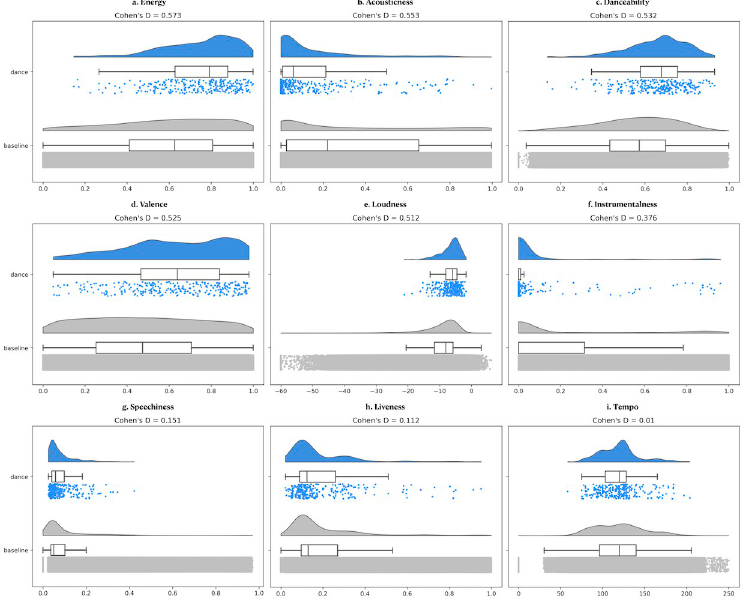
Fig 1. Spotify audio features comparing baseline (grey) and dance (blue) music datasets. Two sample’s t-tests revealed significant differences for all features except for liveness (h) and tempo (i). Calculated with Cohen’s d , medium effect sizes for energy (a), acousticness (b), danceability (c), valence (d), loudness (e), instrumentalness (f); small effect size for speechiness (g) were found. An additional K-S test revealed significant difference between dance and general datasets’ tempo feature (i). To summarise, dance music can be differentiated from the music in general to be typically around 120 bpm, with higher energy, danceability, valence, loudness, and lower acousticness, instrumentalness, and speechiness Spotify audio